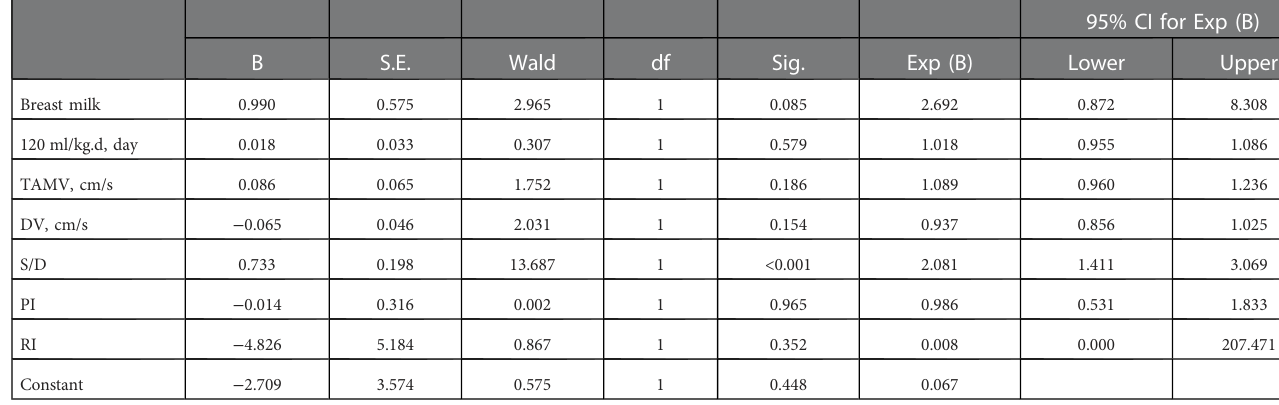
TABLE 3 Logistic regression for the risk of NEC.